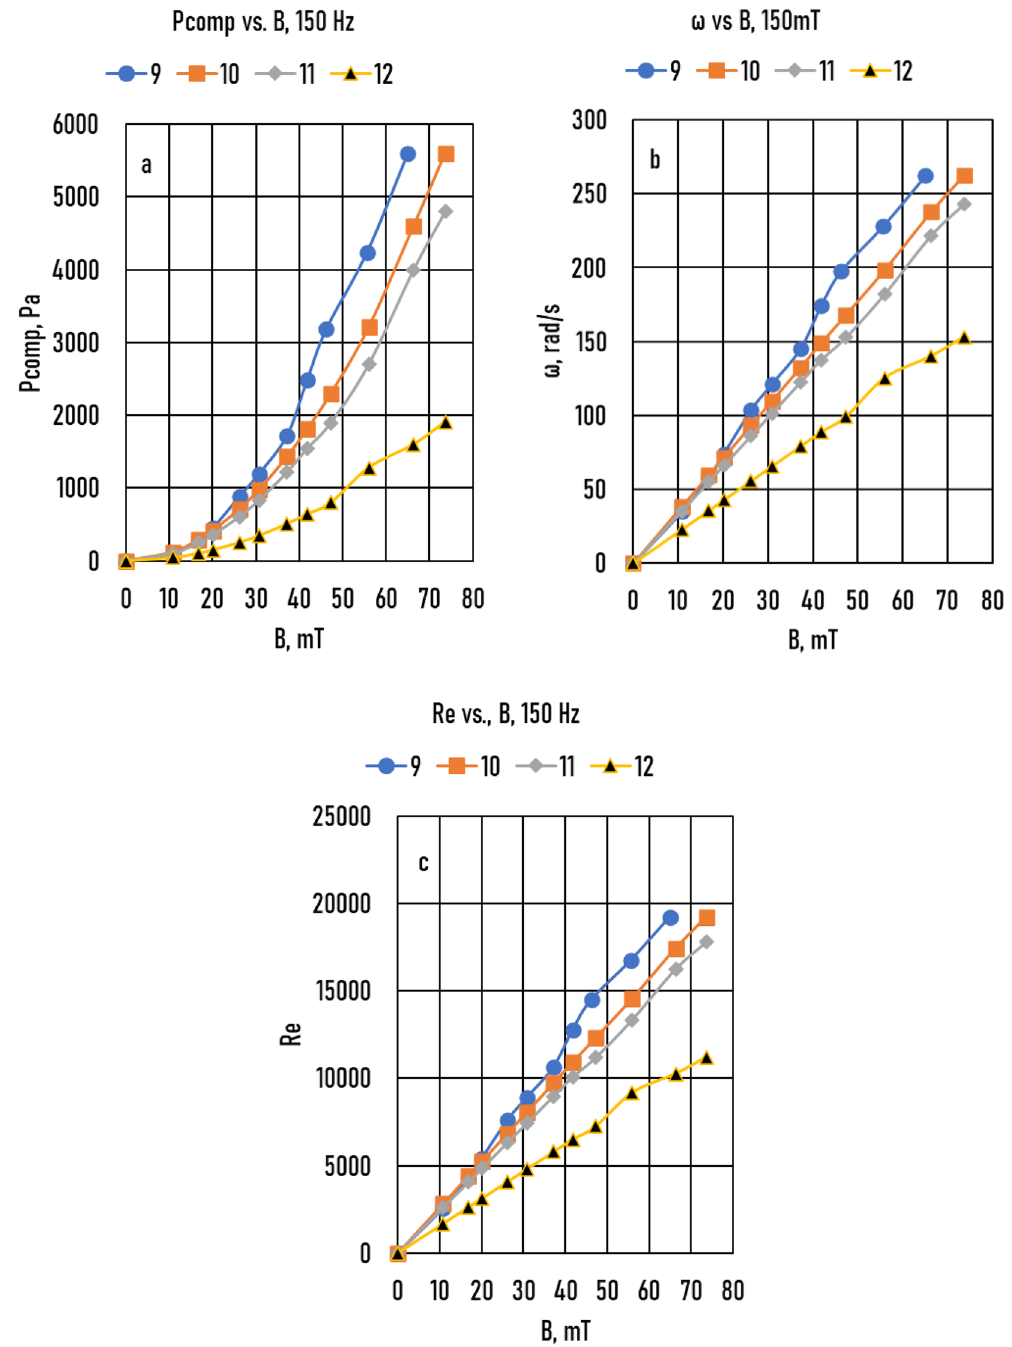
Figure 5. Samples 9 – 12 ( a ) Measured compensation pressure ( P comp ) as a function of magnetic induction ( B ). ( b ) Angular frequency of melt ( ω ) as a function of B . ( c ) The real Reynolds number ( Re ) as a function of B